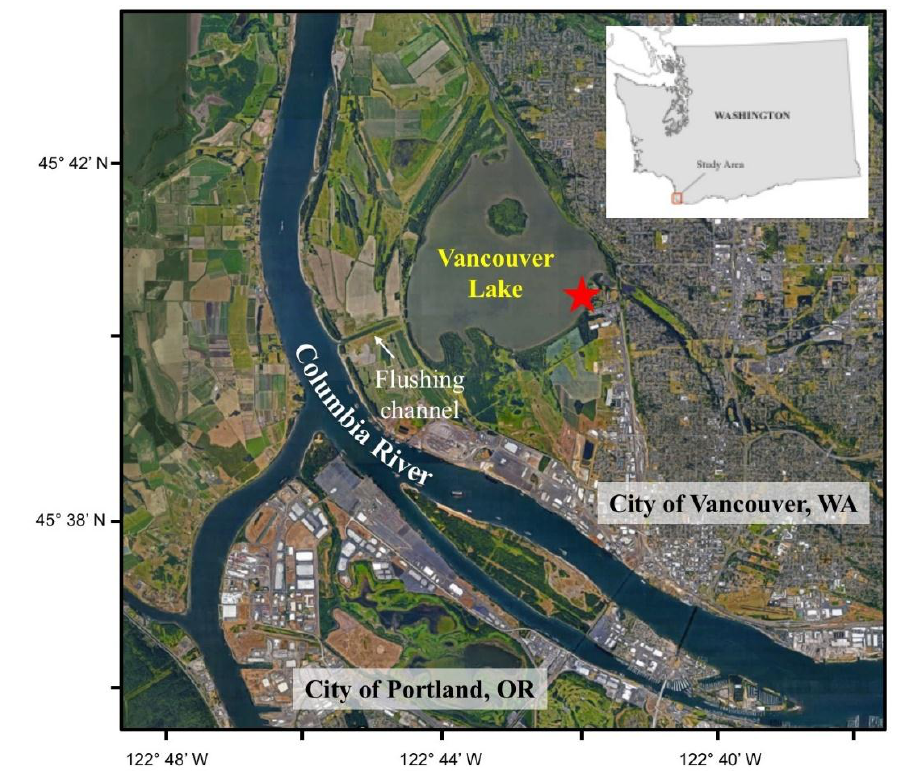
Figure 1. Map of Vancouver Lake located in the city of Vancouver, WA, USA. The Columbia River is the boundary between the states of Washington (north) and Oregon (south). The river is also the boundary between the city of Vancouver, WA and the city of Portland, OR. Star indicates sampling location.